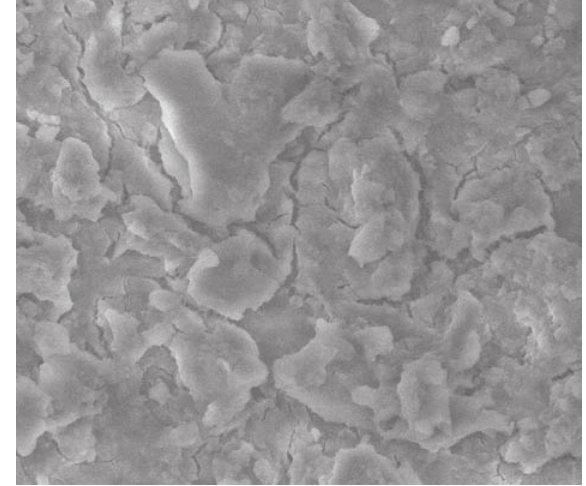
Figure 4- Scanning Electron Microscopy (SEM) micrograph of the smear layer in root canals irrigated with NaOCl and a rinse of EDTA. All dentinal tubules are visible and the smear layer was completely removed